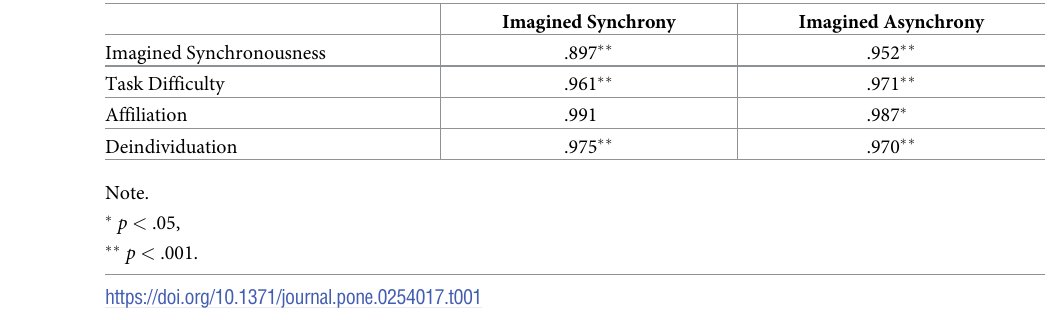
Table 1. Shapiro-Wilk tests for each measure as a function of